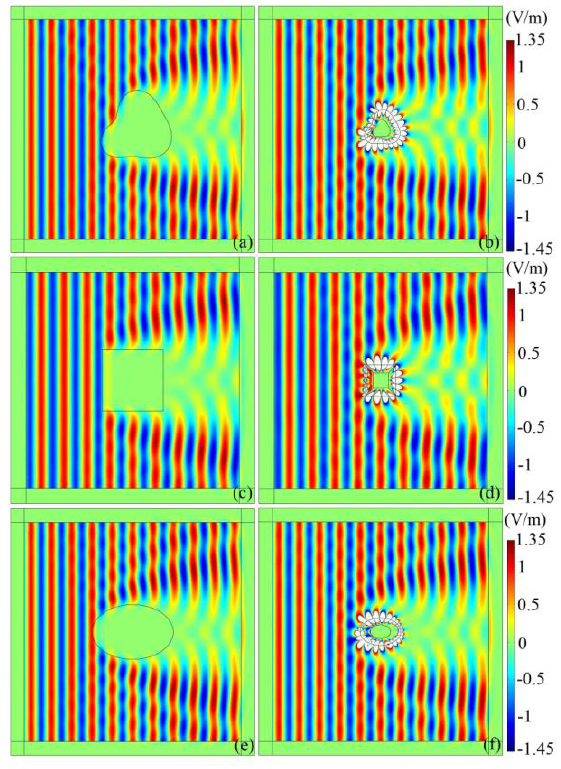
Figure 3. Electric field distribution in the vicinity of the absorbing materials (left column) and the superabsorber (right column) under TE plane wave